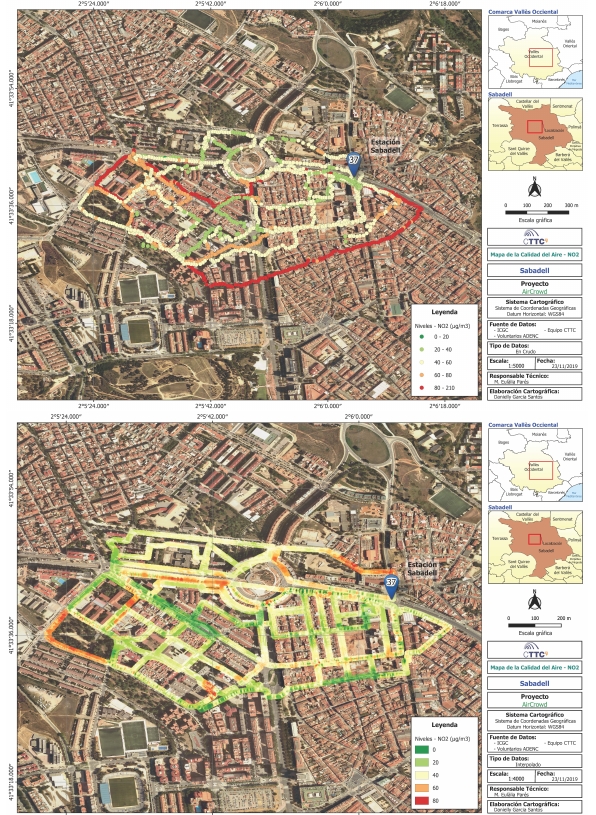
Figure 7. Data set Top.- at 7:30 of a winter’s Thursday and Bottom.- at 7:30 on a winters